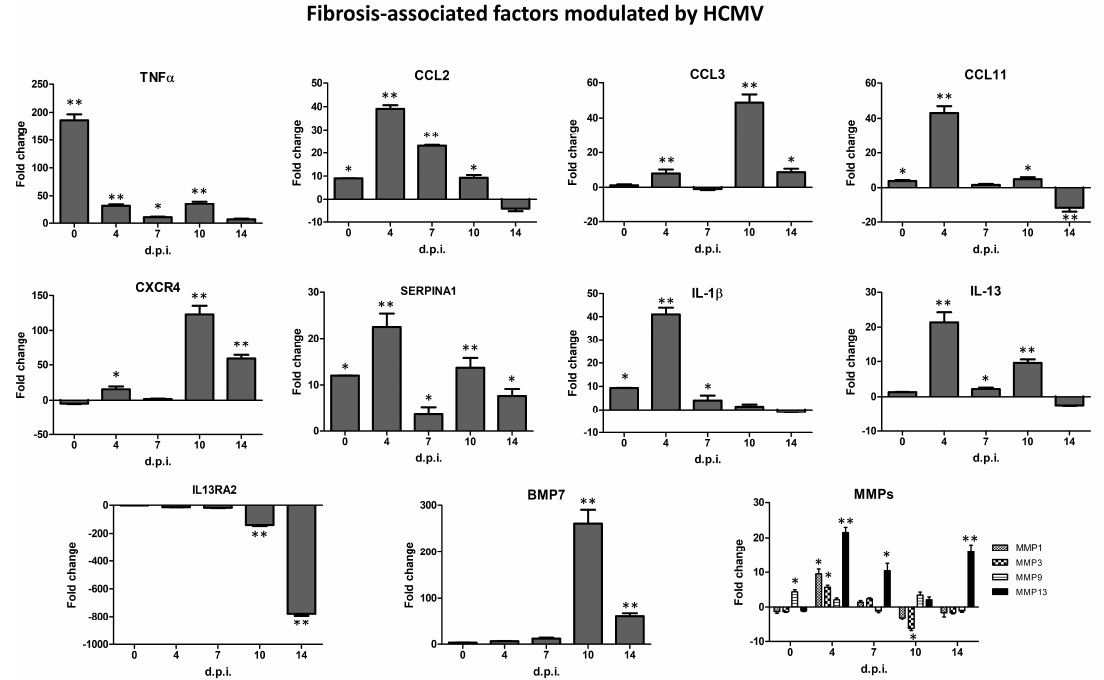
Figure 2. Expression kinetics of fibrosis-associated factors most significantly modulated by human cytomegalovirus (HCMV) infection in primary human dermal fibroblasts. At each time p.i. (d.p.i. = days post-infection), cell samples were collected and analyzed by specific qPCR microarray. Results are expressed as mean values of fold change (infected cells vs. controls) ± SD of duplicate samples from two independent experiments. * pc < 0.01; ** pc <